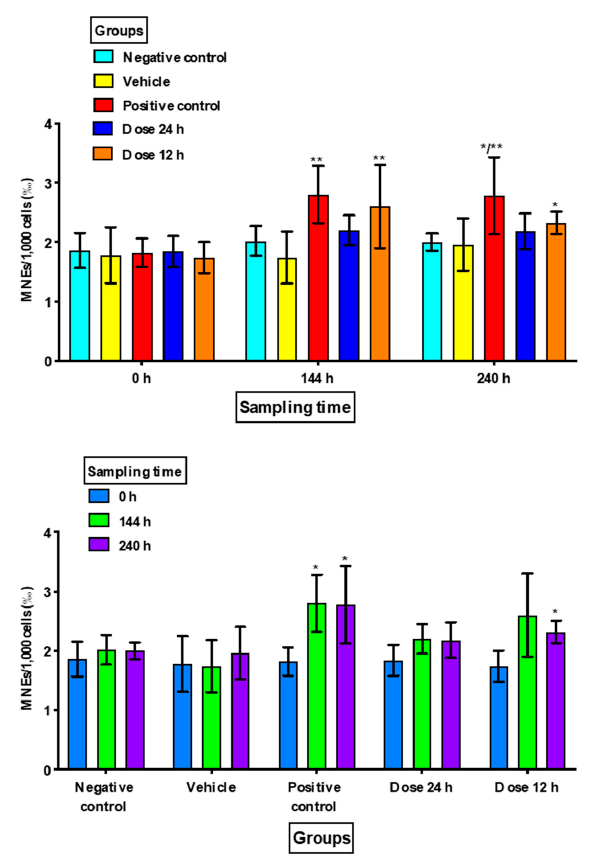
Figure 1. Frequency of micronucleated erythrocytes (MNEs) in the study groups at the different sampling times. Frequency values are expressed as the mean ± standard deviation in 1000 cells (‰). h: hours. Intergroup comparisons were made between the study groups: * versus negative control and ** versus vehicle. Intragroup comparisons were made between the * basal value (0 h) and sampling times (144 and 240 h).